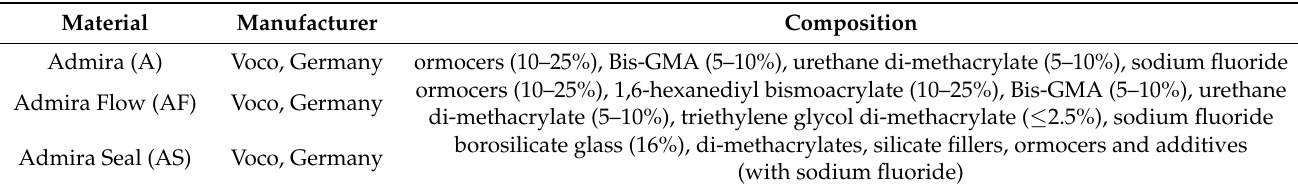
Table 1. Composition of dental